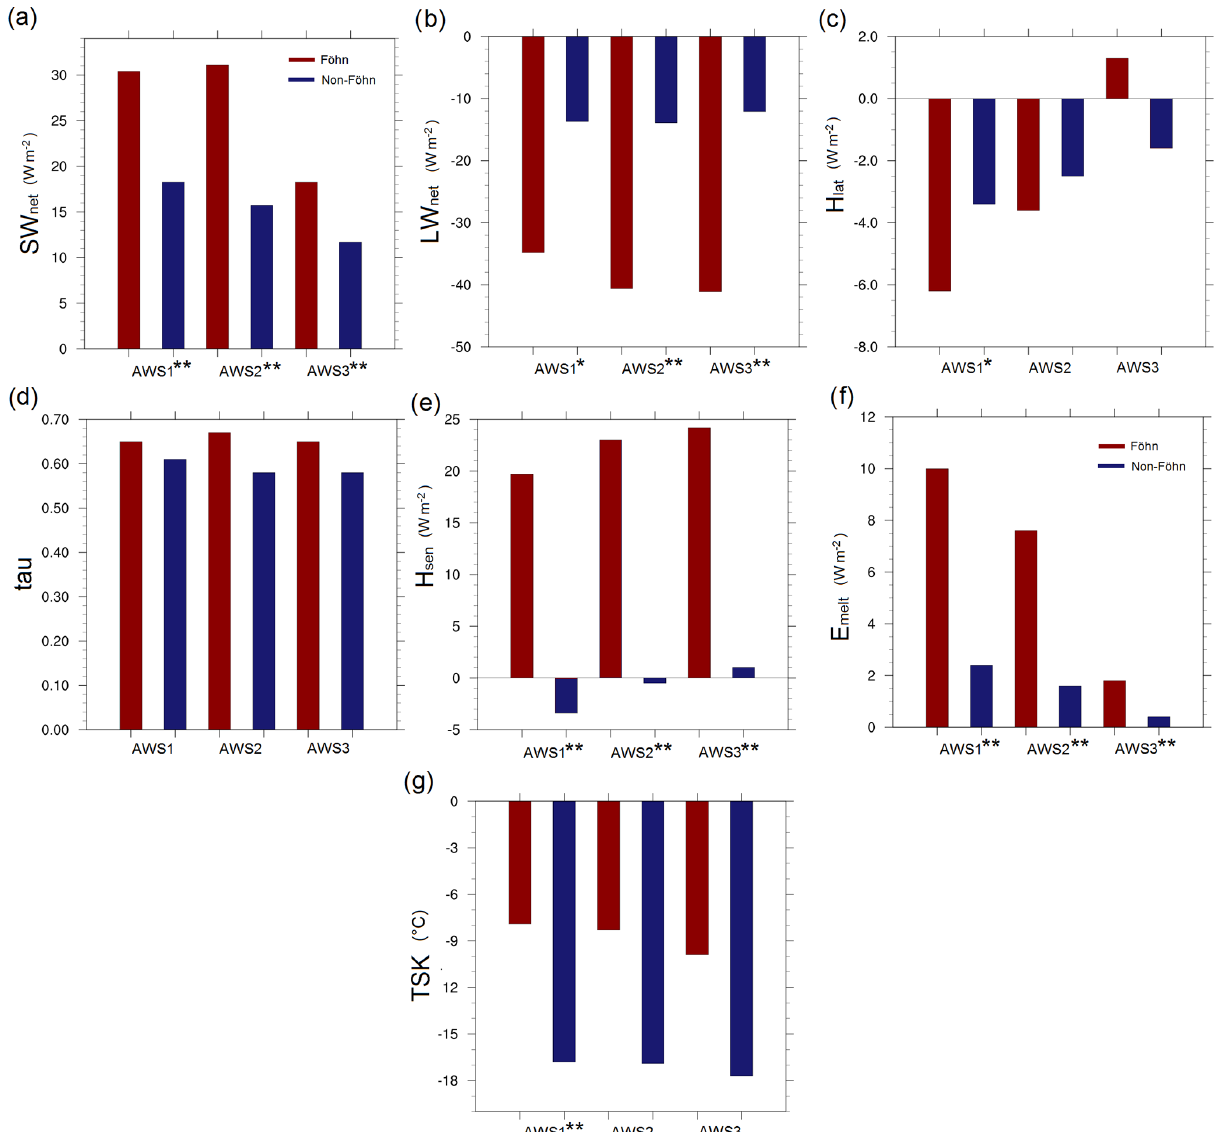
Figure 4. The mean shortwave net radiation (a) , longwave net radiation (b) , latent heat flux (c) , τ (d) , sensible heat flux (e) , E melt (f) and skin temperature (g) from the three locations during all föhn (red) and non-föhn (blue) periods from 2009 to 2012. * indicates a statistically significant difference between non-föhn and föhn values at the 95% confidence level using the t test, and ** indicates the same at the 99% confidence level. Differences were not assessed for τ , derived from the average SW and SW top , owing to small sample